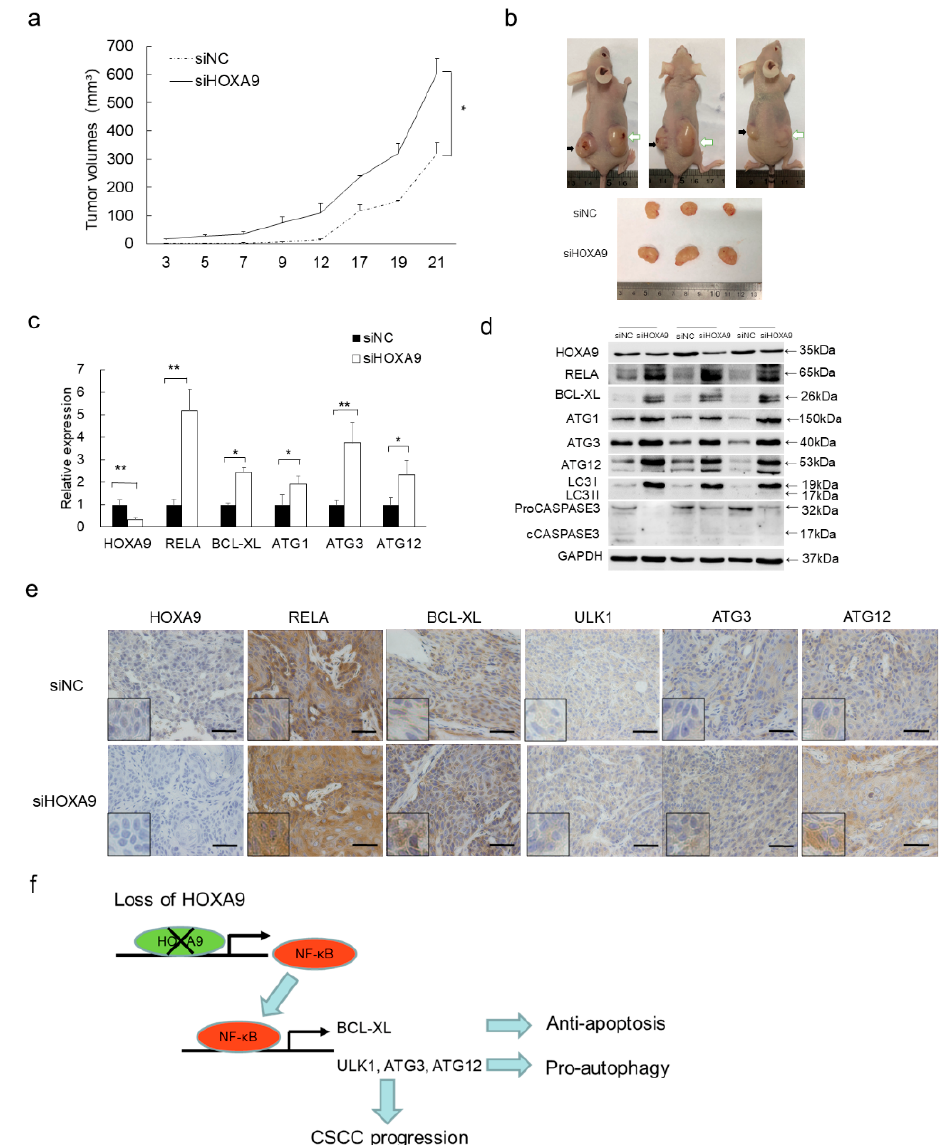
Figure 4. Loss of HOXA9 inhibited apoptosis, promoted autophagy and tumor growth in vivo. ( a ) HOXA9 depletion enhances xenografts growth. Statistical data of tumor volumes represent the average of three independent experiments ± s.d, respectively. ( b ) Dissected xenografts from three sacrificed mice were imaged at the end of experiment. Black arrows point the siNC-treated xenografts while white arrows indicate siHOXA9-treated xenografts. ( c ) The expression of HOXA9 , RELA , BCL-XL , ULK1 , ATG3 , and ATG12 was detected in the dissected xenografts by qRT-PCR. Statistical data of qRT-PCR represent the average of three independent experiments ± s.d. ( d ) The protein expression levels of HOXA9, RELA (p65), BCL-XL, ULK1, ATG3, and ATG12 was detected in xenografts after siHOXA9 treatment by western blot. ( e ) Histopathology analysis (IHC staining) of HOXA9, RELA (p65), BCL-XL, ULK1, ATG3, and ATG12 on tumor sections. Scale bar, 100 µ m. ( f ) A model of the HOXA9-NF- κ B regulatory axis in cSCC development. In cSCC tumors, loss of HOXA9 up-regulates NF- κ B and its downstream anti-apoptotic gene BCL-XL and pro-autophagic genes of ULK1 , ATG3 , and ATG12 , which contributes to the repressed apoptosis, enhanced autophagy and promotes cSCC progression. * p < 0.05, ** p < 0.01, or *** p < 0.001.